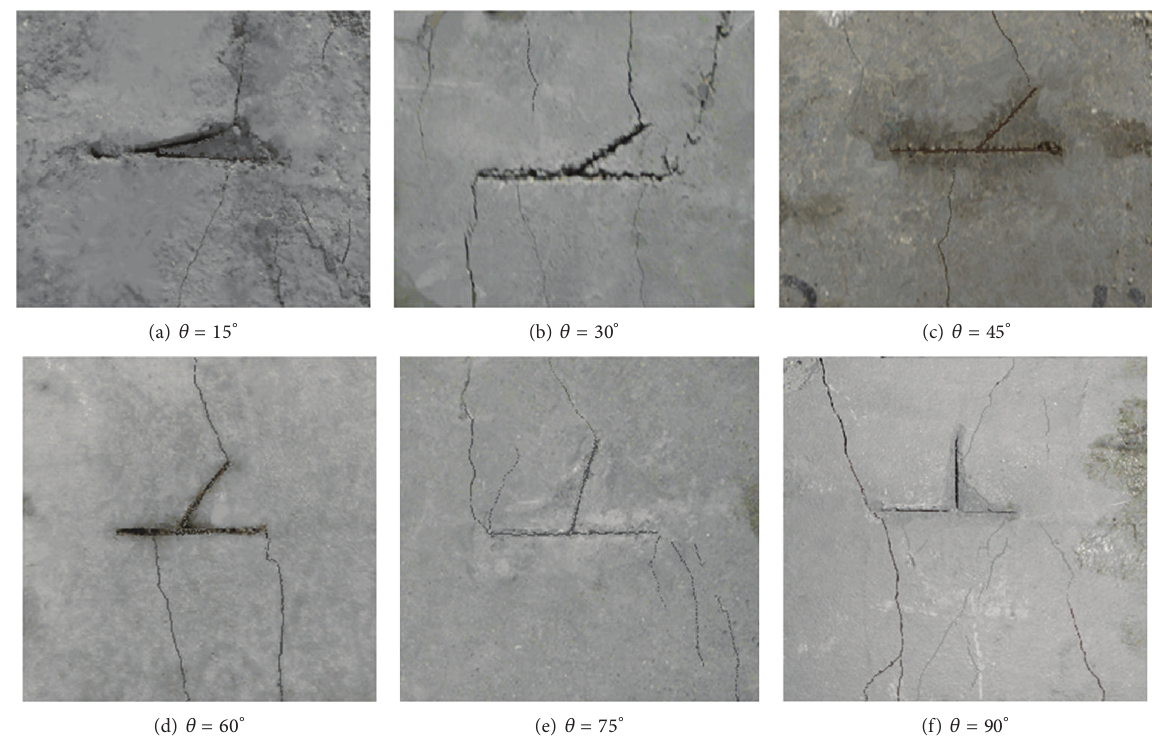
Figure 3: Test result of the fracture patterns for the specimens with different branch angles.